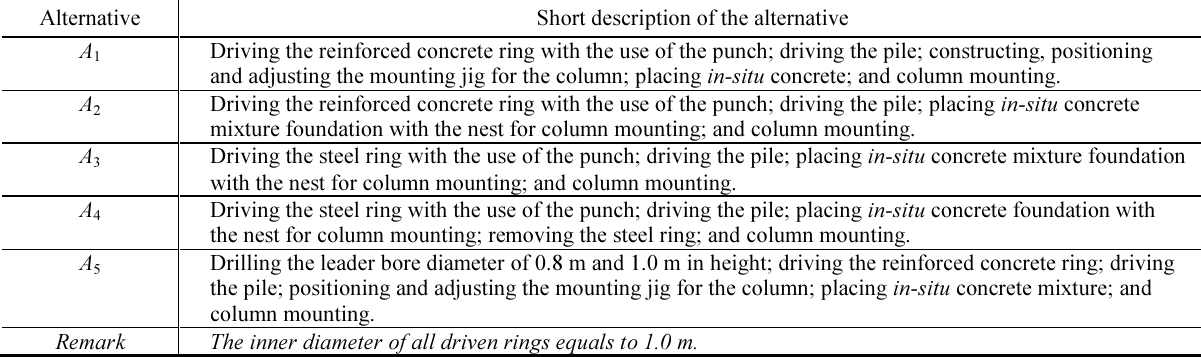
Table 2. The workflow statistics of installed pile-columns, when reinforced concrete ring is driven (alternative A construction in Marijampolė Process